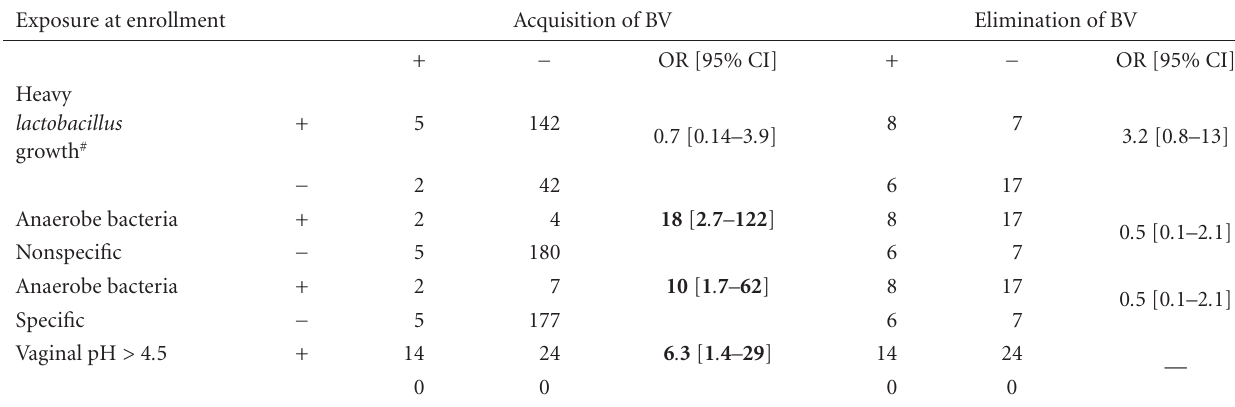
Table 3: Microbiological risk factors for the acquisition or elimination of bacterial vaginosis (Amsel’s criteria) in pregnancy. ( N = 229). Exposure at